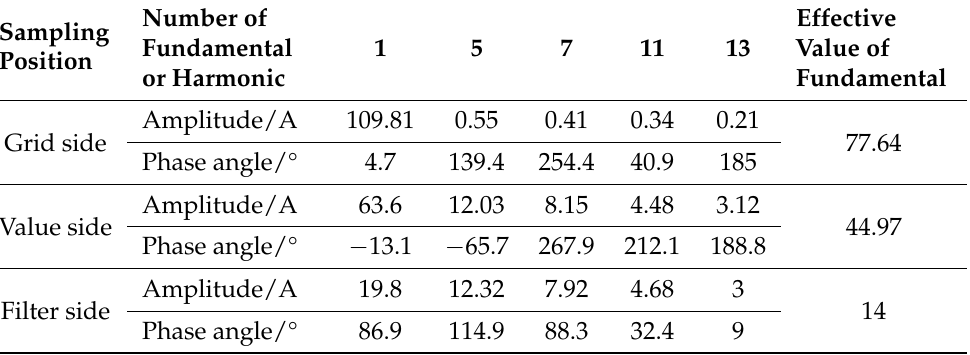
Table 4. Current values from each winding at phase A under the rated operation of the inductive filter converter transformer with the YDD